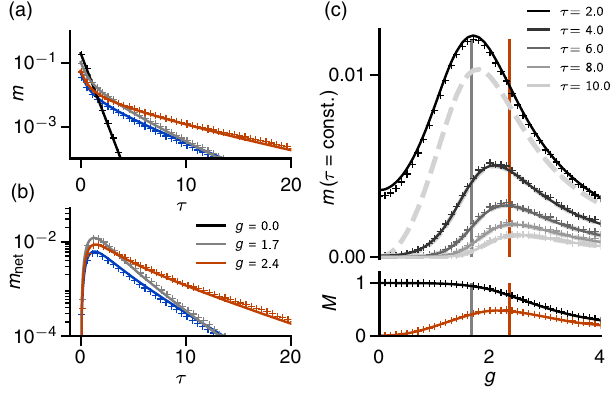
FIG. 6. Sequential memory. Mean-field prediction (solid curves) and simulation results (crosses). (a) Memory (28) as a function of time lag τ between signal and readout for different coupling strengths encoded in color [legend in panel (b)] for σ ¼ 1 and additionally for colored background noise with τ 2 for n ¼ g ¼ 2 . 4 and σ ¼ 1 (blue). (b) Corresponding network contribu- tion (29) to memory. (c) Upper part of vertical axis: Memory at different time lags τ as a function of coupling strength g . Network contribution to memory shown as dashed thick light-gray curves, which coincide with total memory curves for τ ≥ 4 . The vertical gray line marks local instability (18), and the vertical red line marks the transition to chaos [cf. Fig. 3(b)]. Lower part of vertical axis: Memory capacity M (black), Eq. (30), and network contribution to memory capacity, M net